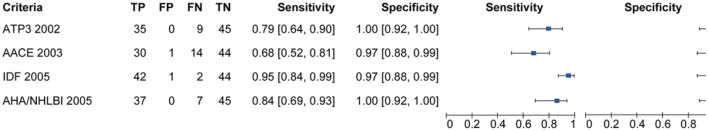
Tabulation and graphical plot of sensitivities and specificities.